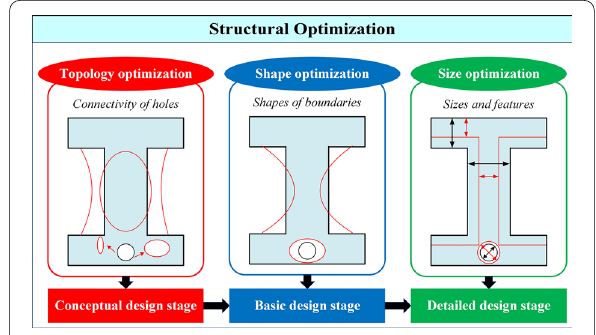
Figure 1 Structural